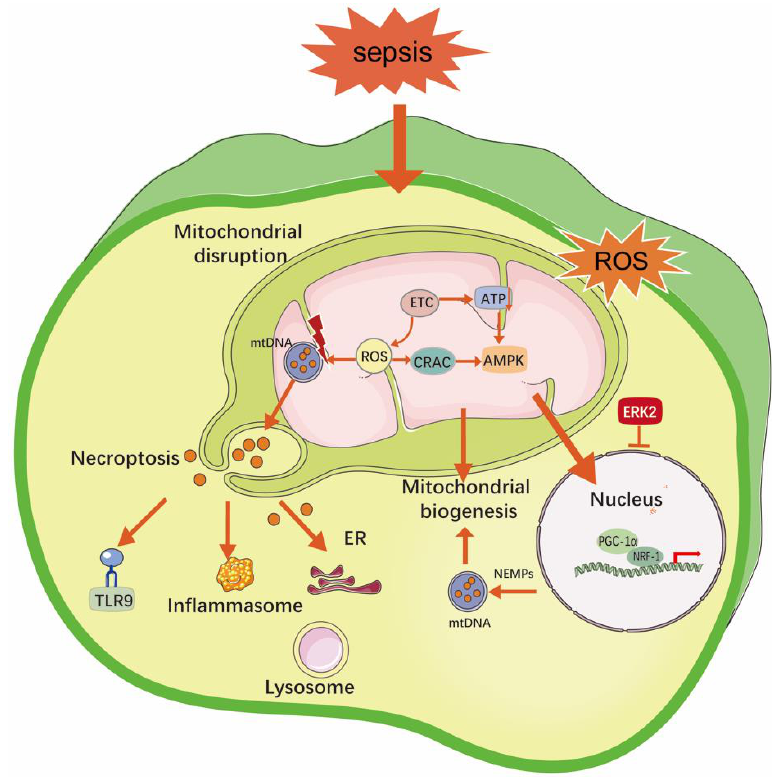
Figure 2. The regulation mechanisms of mitochondrial damage during sepsis.